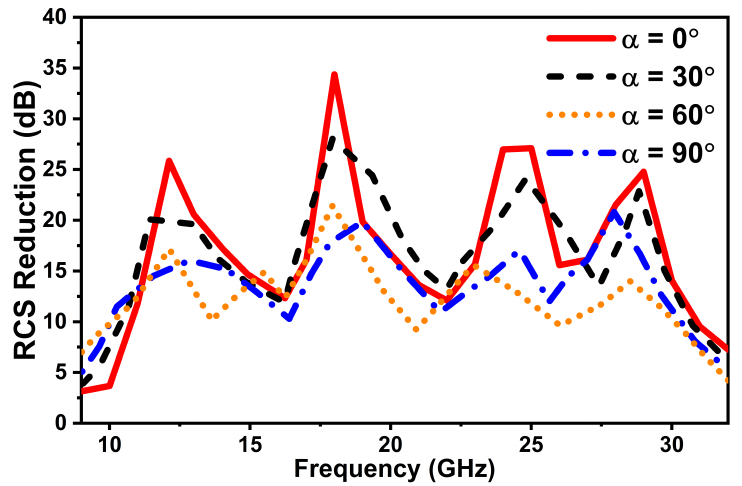
Figure 16. Monostatic RCS reductions results of a coding metasurface for various central angles ( α